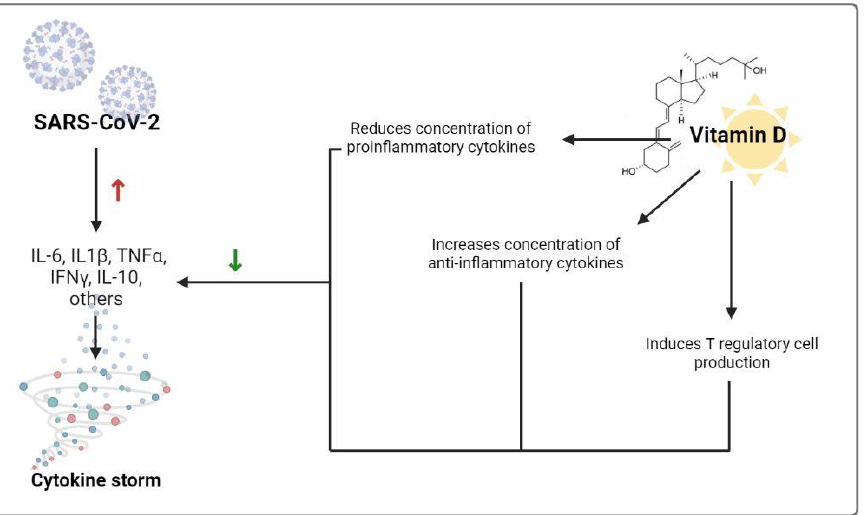
Figure 1. Mechanisms by which vitamin D could decrease the risk of cytokine storm. Red upward arrow indicates an increase while the green downward arrow indicates a decrease. Abbreviations: IL-6 = Interleukin-6; IL-1 β = Interleukin-1 β ; TNF α = tumor necrosis factor α ; INF γ = interferon γ ; IL-10 = Interleukin-10.